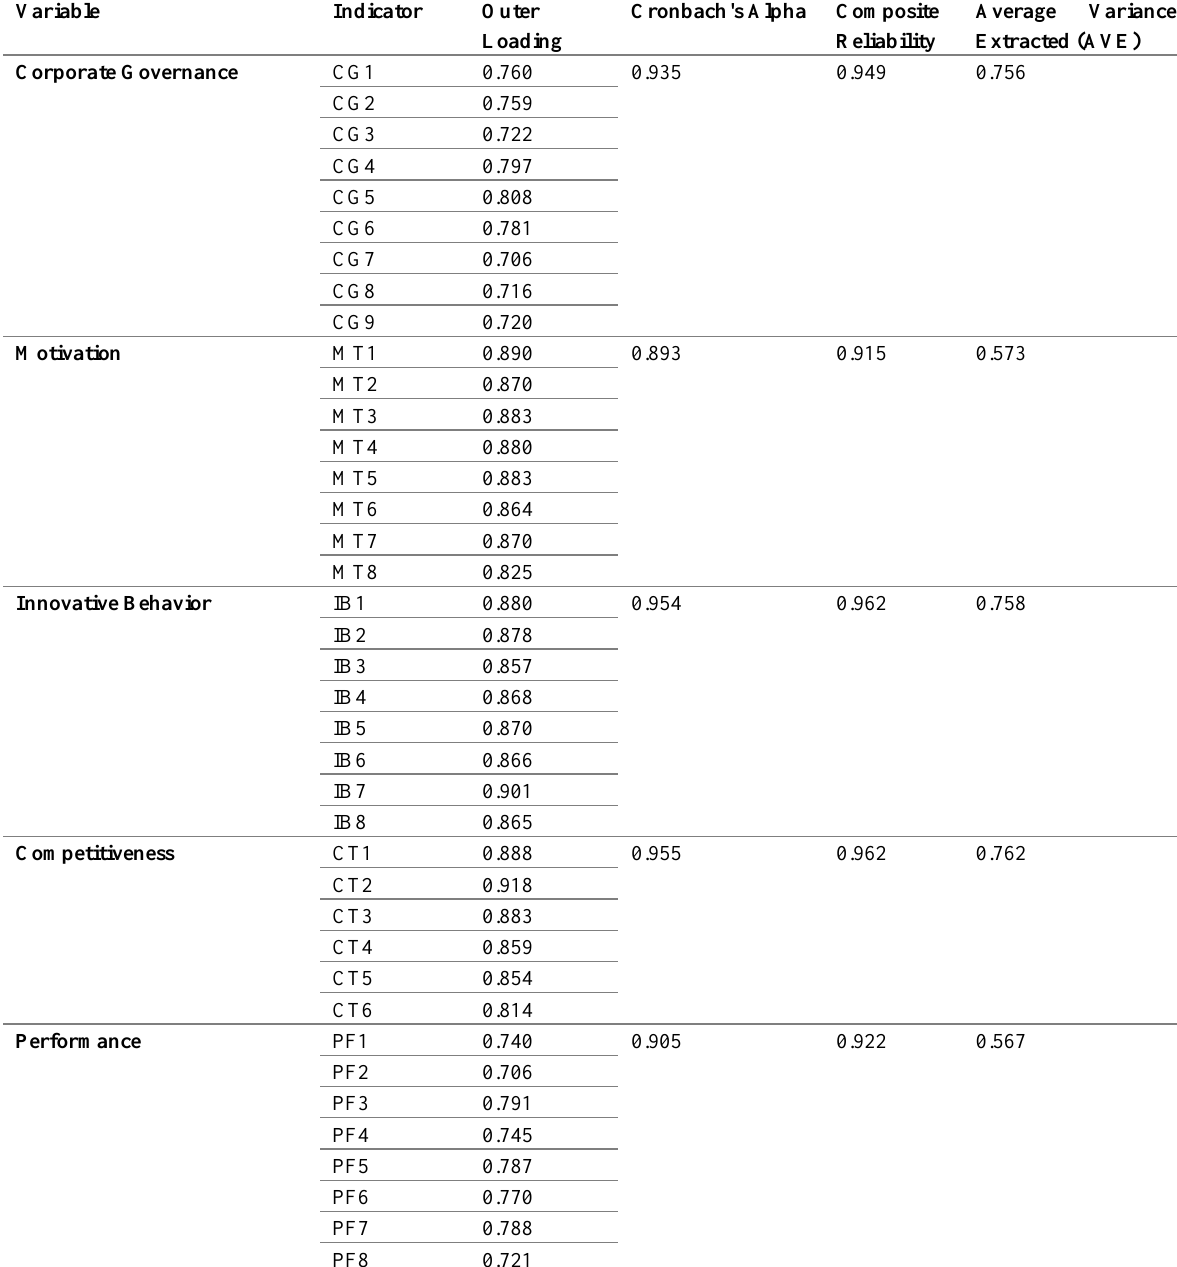
Table 1: Validity and Reliability